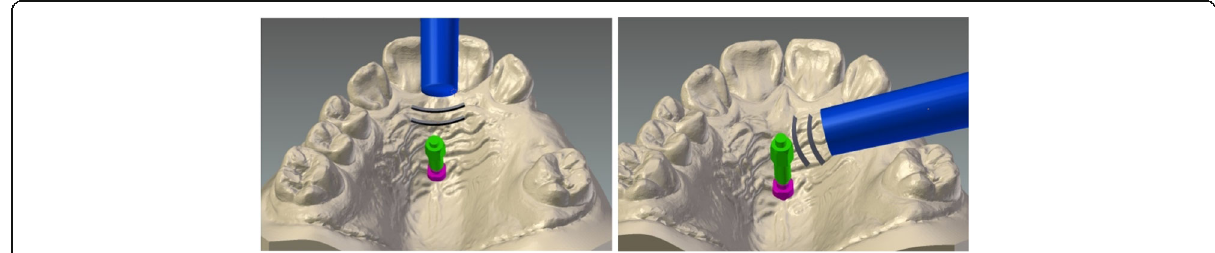
Fig. 2 Measurement technique using the Osstell mentor. Left, parallel to the midpalatal suture. Right, perpendicular to the midpalatal